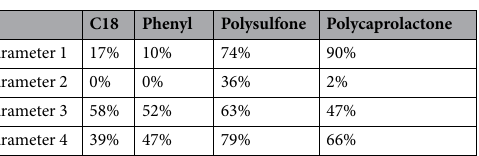
Table 2. Usage rate of each parameter in top 100 combinations when four sensor channels are